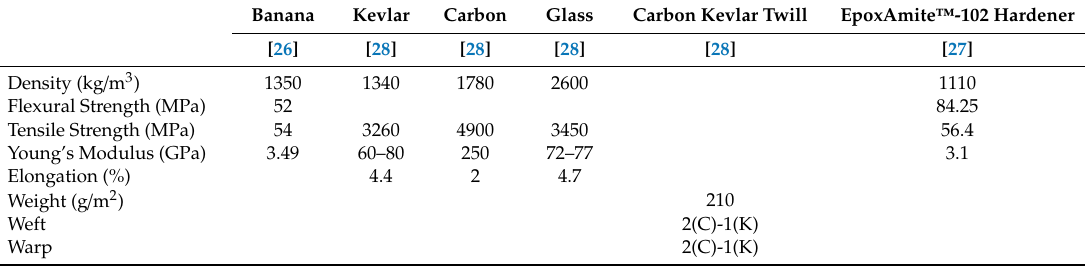
Table 1. Properties of fibers, skins, and EpoxAmite ™ -102